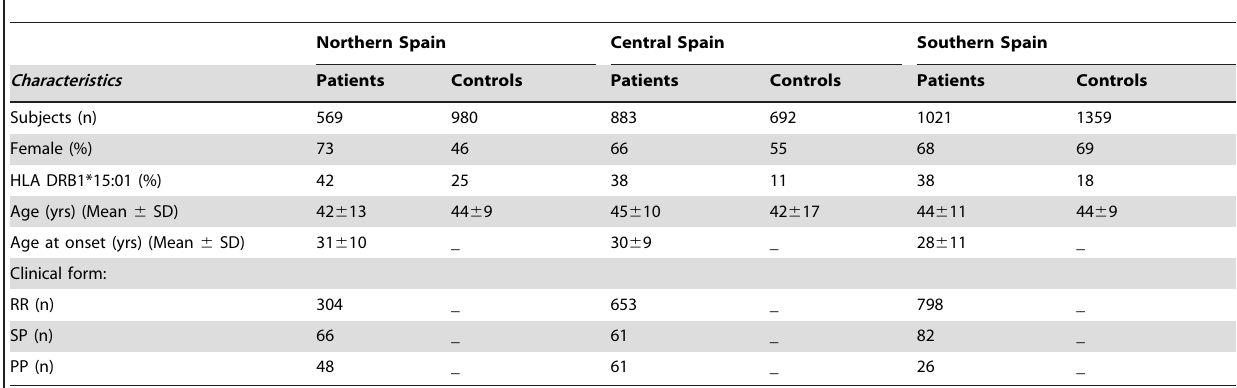
Table 1. Demographic characteristics of the MS patients included in the study.